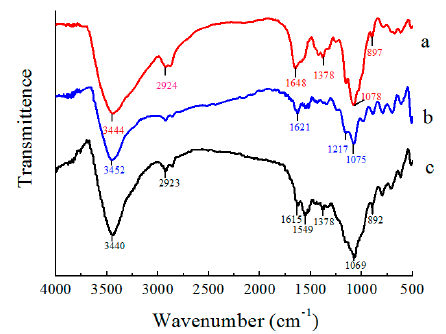
Figure 3. FT-IR spectra of aerogels: ( a ) CS, ( b ) GO, and ( c ) CS/GO.